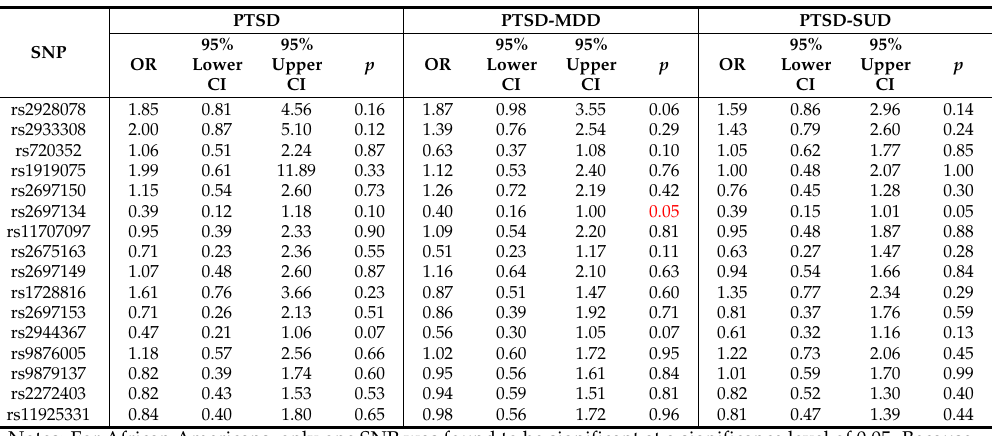
Table A2. The effect of each SNP on the risk of PTSD (i.e., individuals with only Posttraumatic Stress Disorder), PTSD-MDD (i.e., comorbid Posttraumatic Stress Disorder and Major Depressive Disorder), and PTSD-SUD (i.e., comorbid Posttraumatic Stress Disorder and Substance Use Disorder) in African-Americans, adjusting for age, sex and